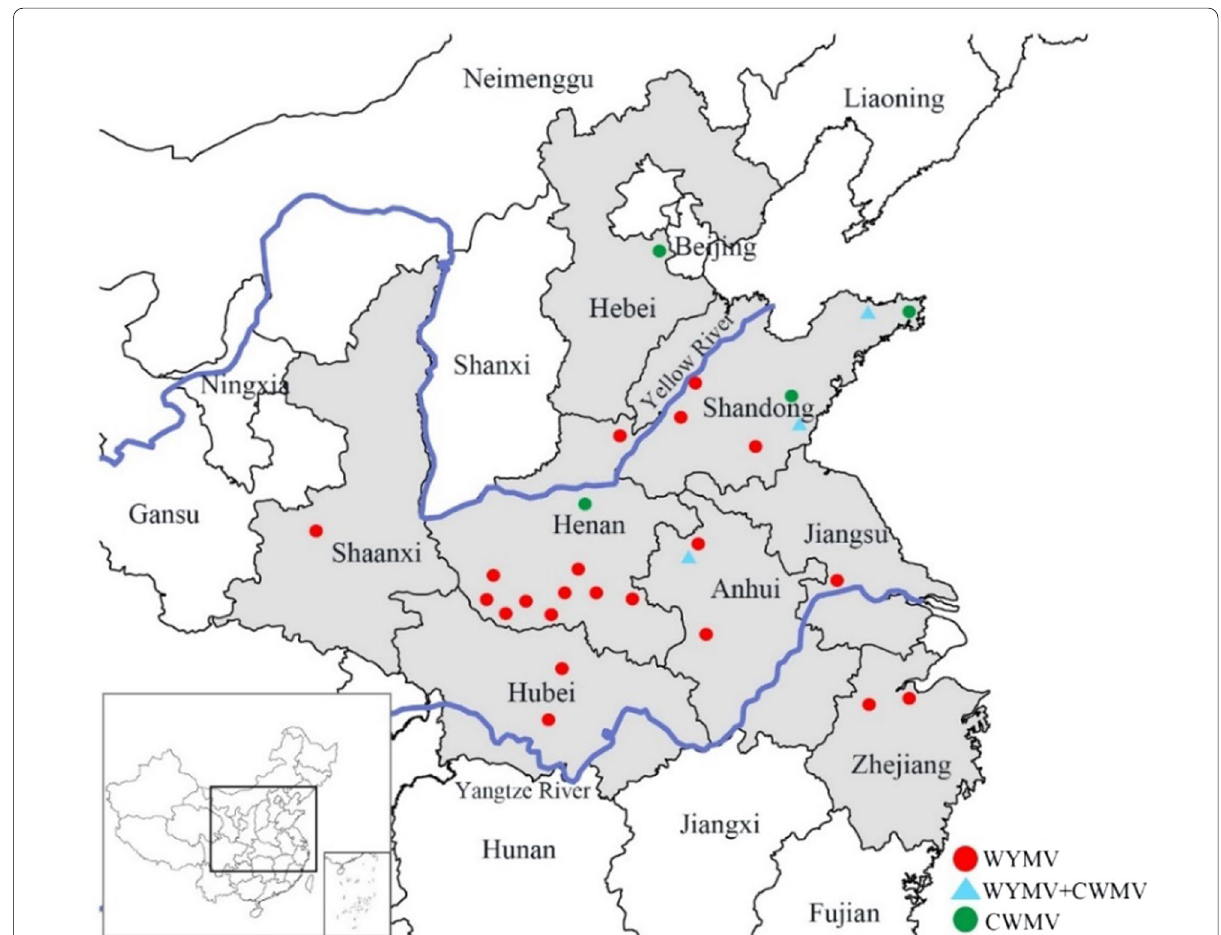
Fig. 2 Distribution of wheat yellow mosaic virus (WYMV) and Chinese wheat mosaic virus (CWMV) in China. Shading shows the extent of WYMV and CWMV occurrence in winter wheat. Samples with WYMV are shown as red circles, CWMV as green circles, and sites with both viruses as blue